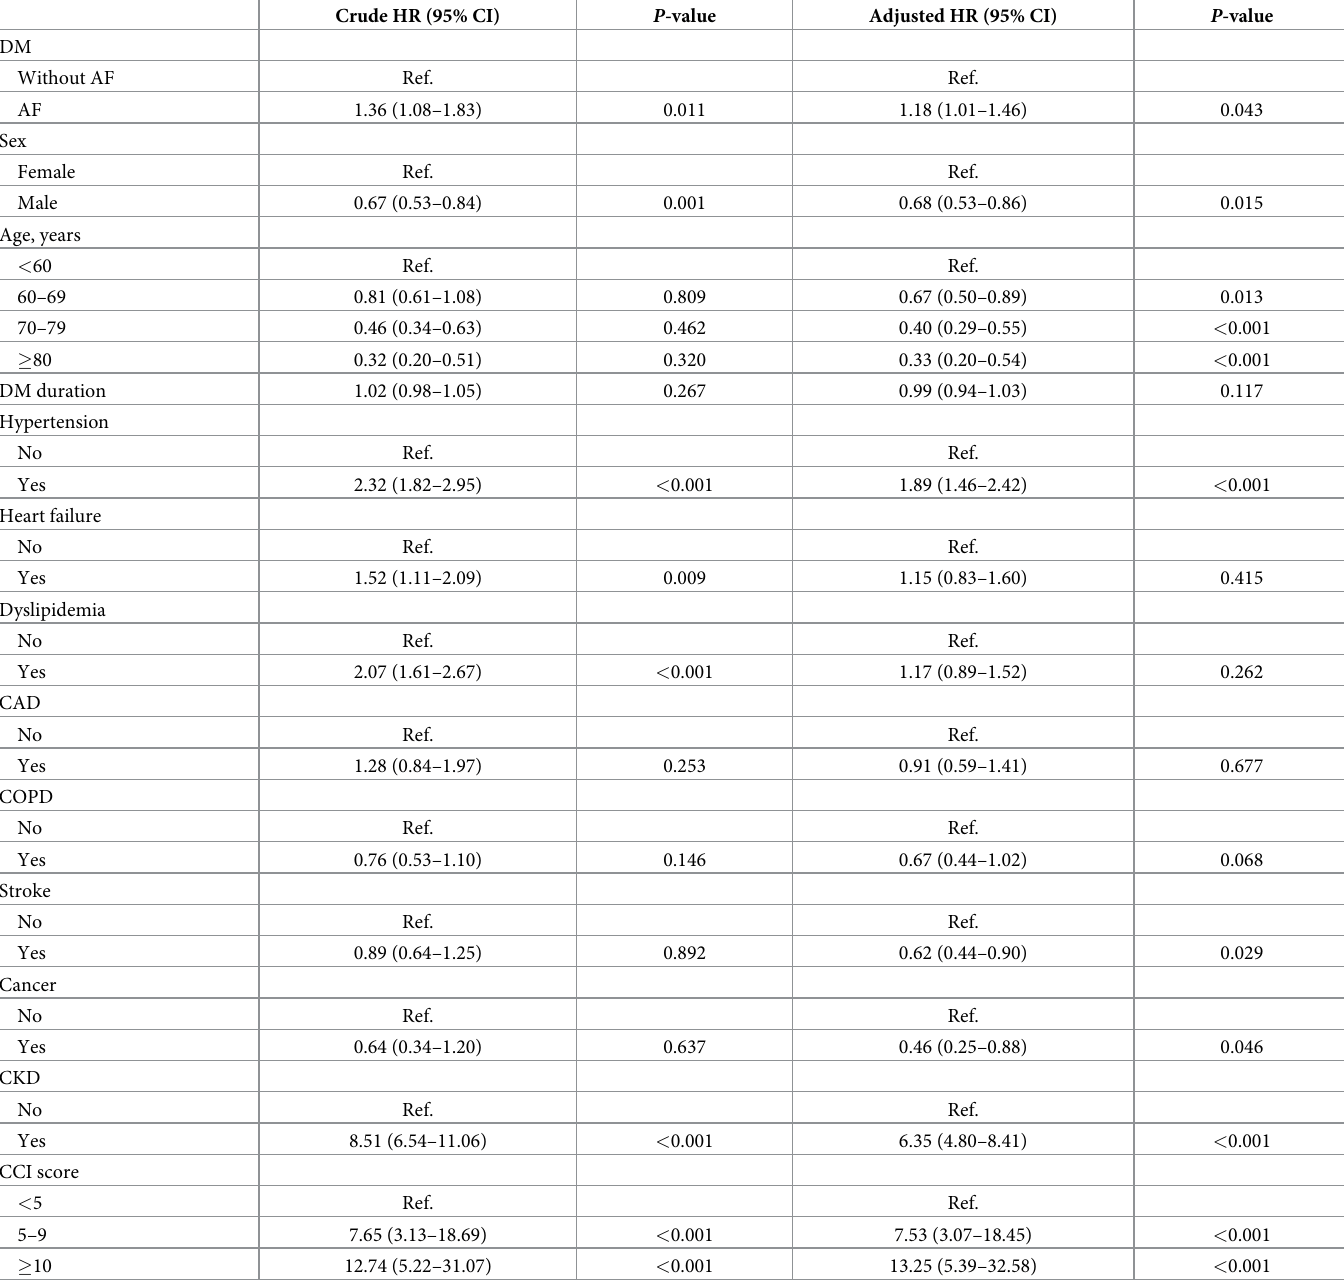
Table 2. Association of DM progression to ESRD with AF, sociodemographic characteristics, and